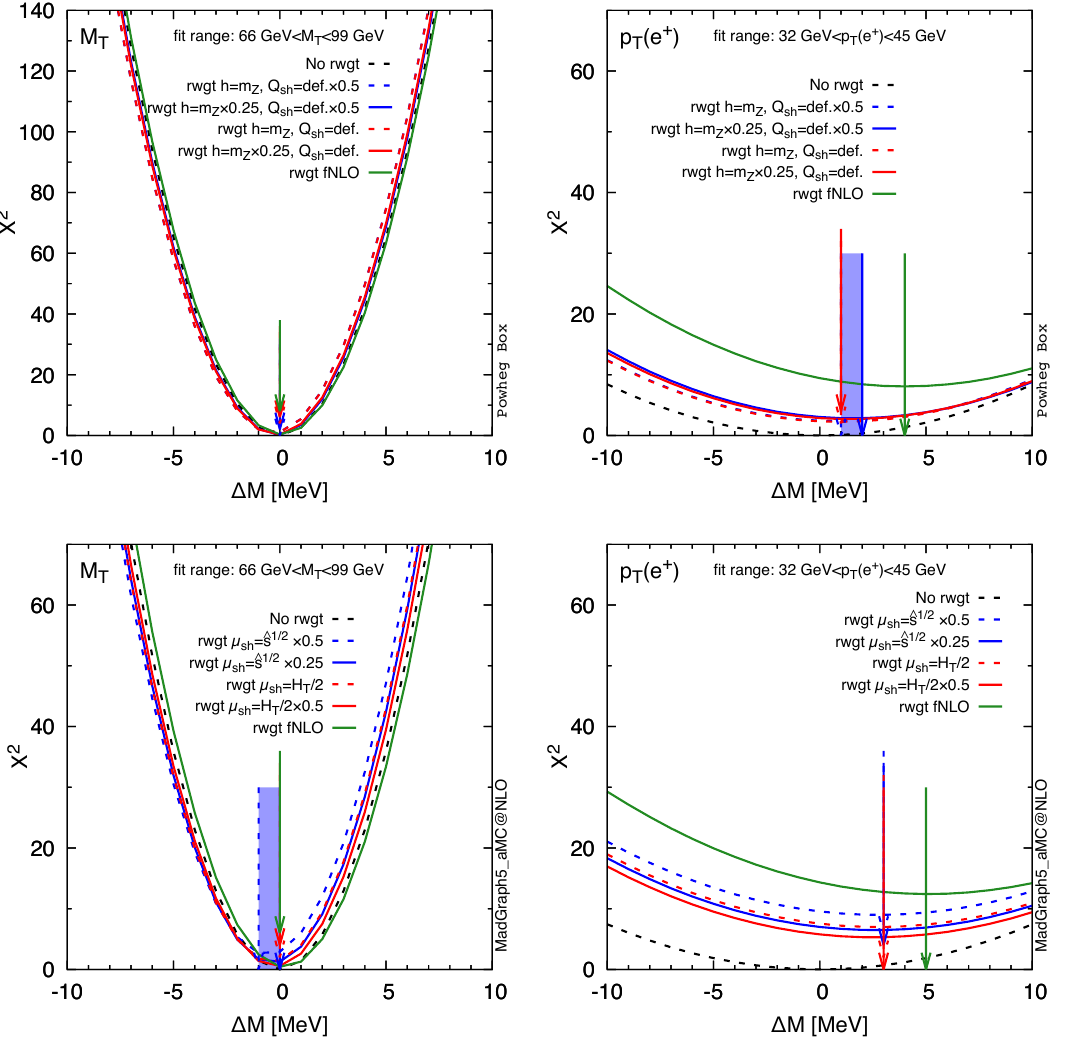
Figure 14 . Result of the template (cid:12)t to distributions that include the improved bottom-quark e(cid:11)ects in di(cid:11)erent QCD